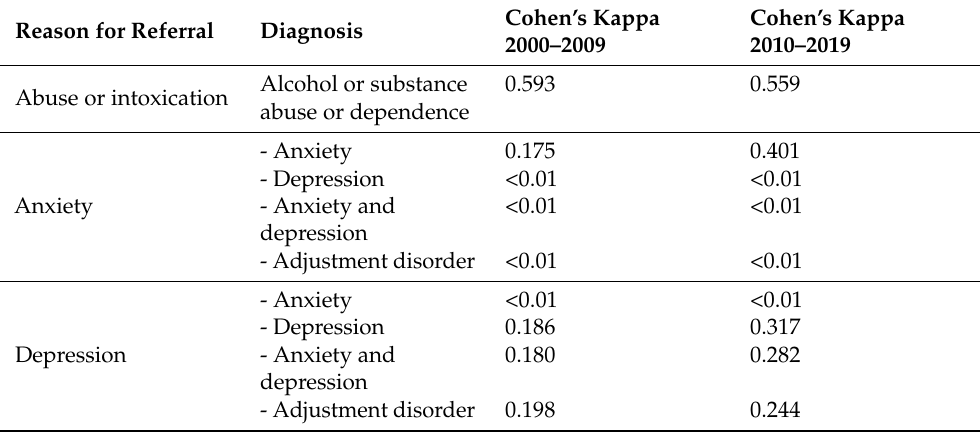
Table 6. Comparison of inter-rater agreement: 2000–2009 (first 10 years) vs. 2010–2019 (second 10